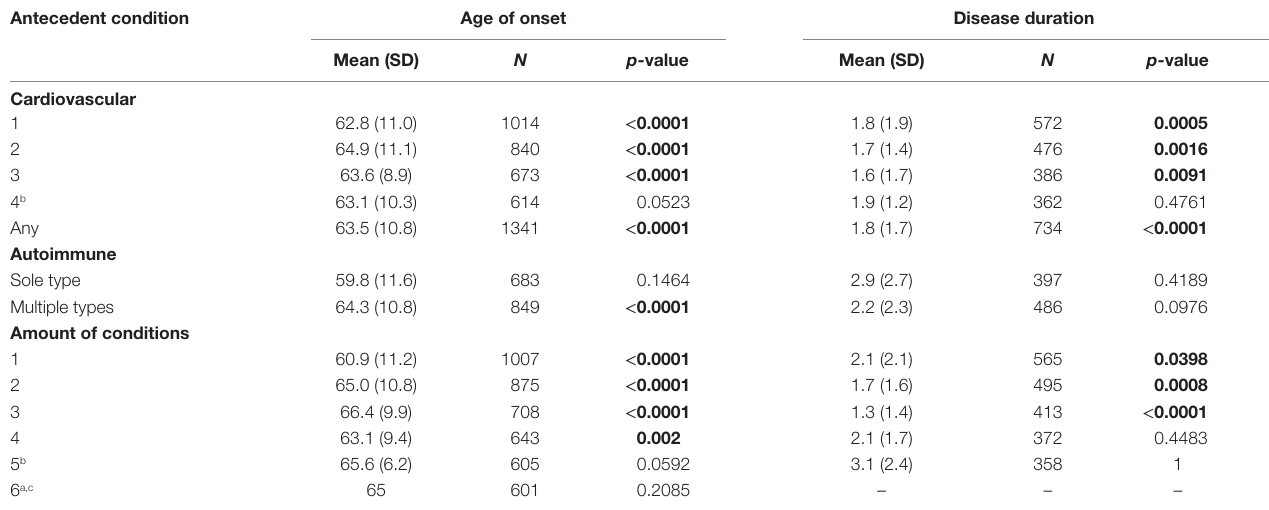
Chi square analysis with population distribution above or below the mean of the total population (60.1 for age of onset and 2.12 for disease duration). Mean (SD) is in years, represents age of onset or disease duration. Bold represents statistical significance. a Sample size of